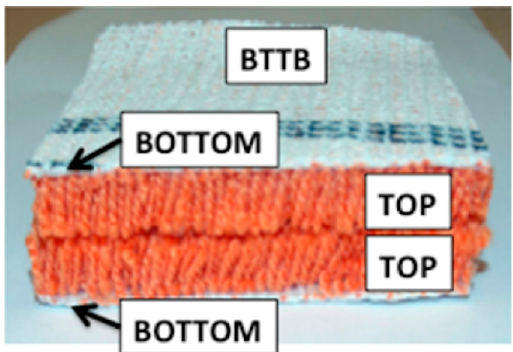
Figure 1. Configuration of carpet preform for fabrication of composite.